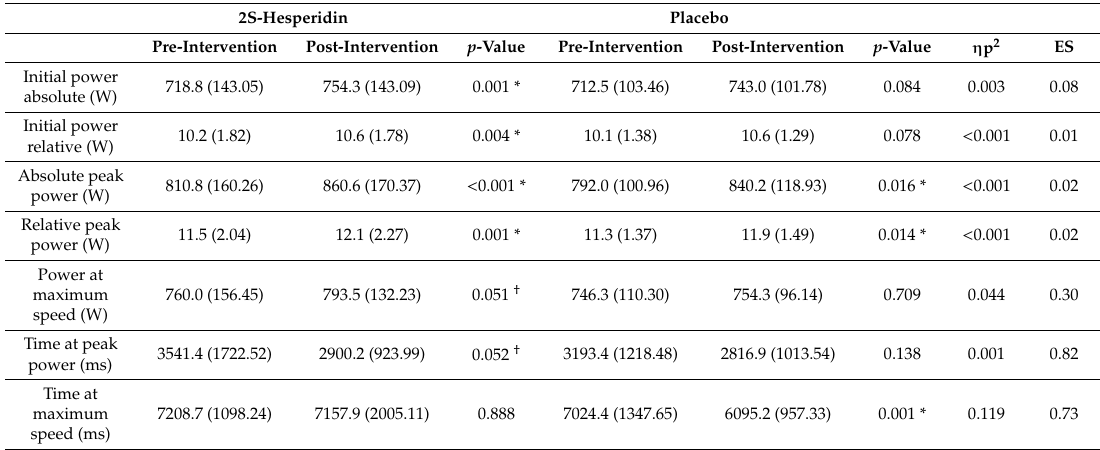
Table 4. Changes in performance parameters in the Wingate